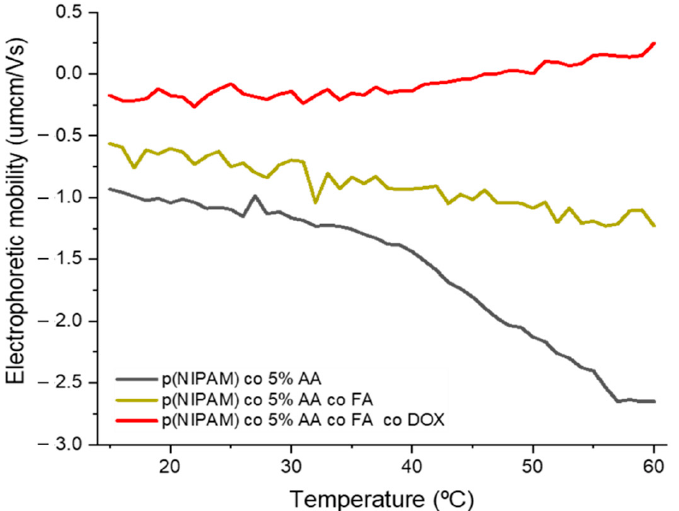
Figure 3. Electrophoretic mobility change of for p(NIPAM)-co-5%AA, p(NIPAM)-co-5%AA-co-FA, and p(NIPAM)-co-5%AA-co-FA-co-Dox versus temperature change (heating cycle). At 15 °C, p(NIPAM)-co-5%AA had a negative electrophoretic mobility of average - 0.946 µmcm/Vs. While that of p(NIPAM)-co-5%AA-co-FA average E m is − 0.401 µmcm/Vs,